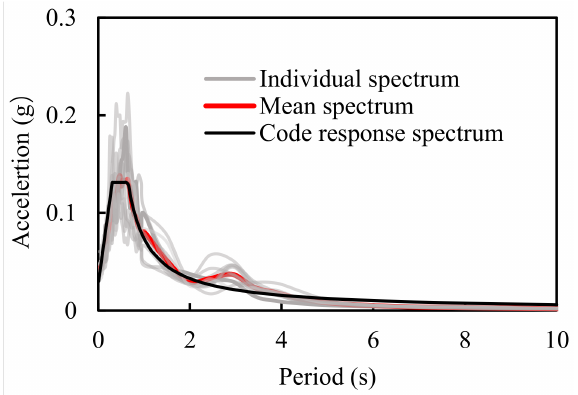
Figure 7. Acceleration response spectra of selected earthquake motion